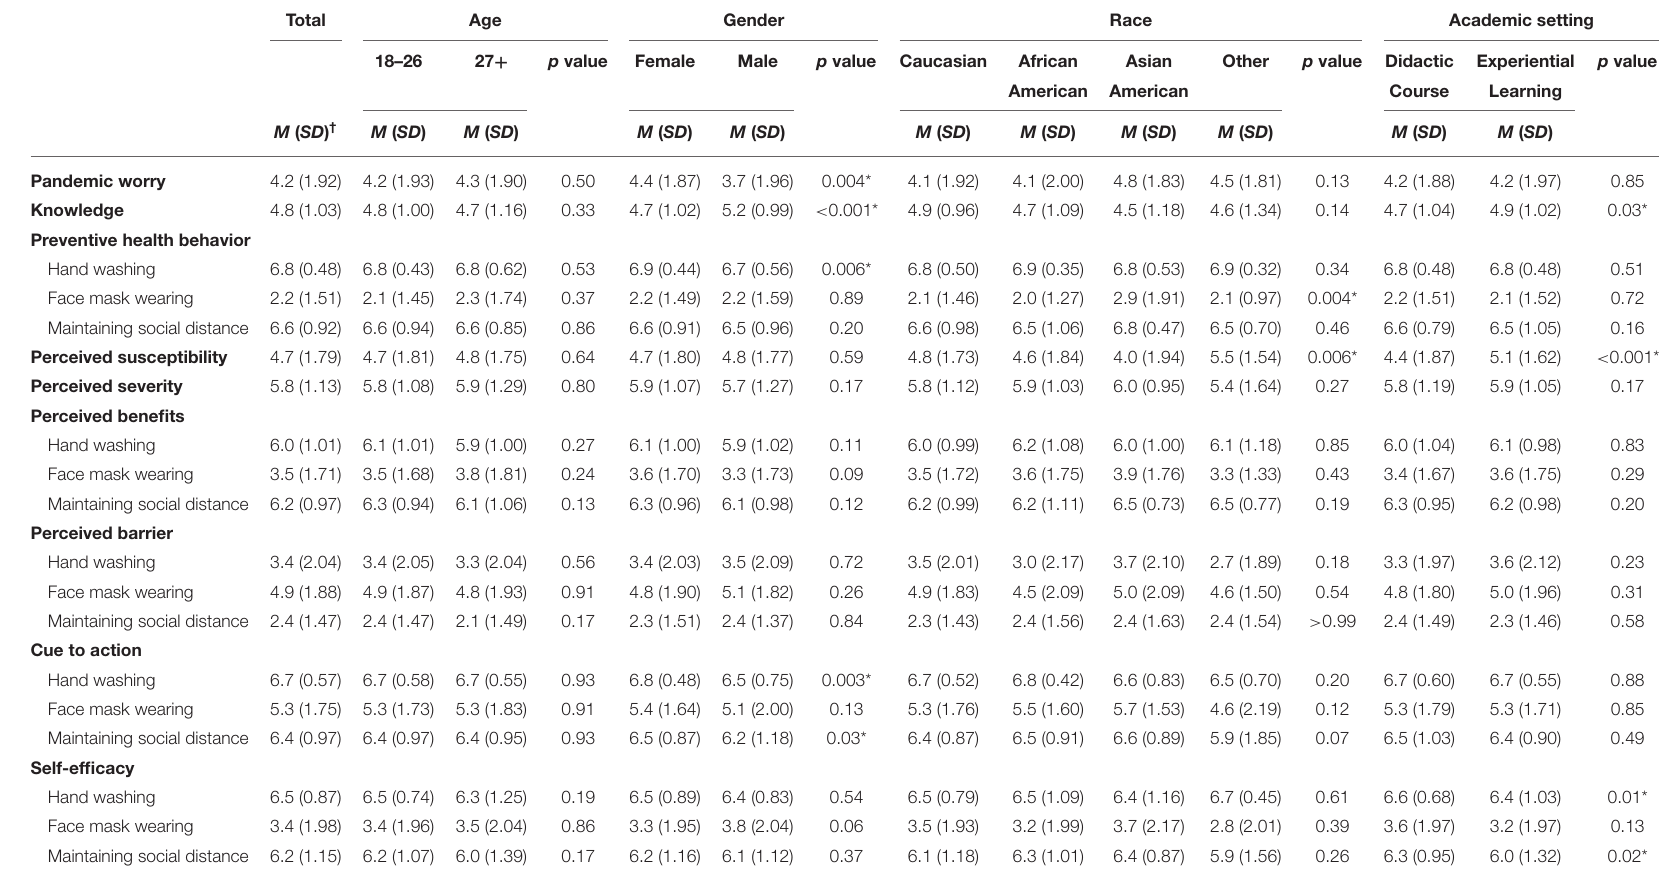
TABLE 2 | Pandemic worry, knowledge, and preventive health behaviors of study participants by age, gender, race, and academic setting. Total Age Gender Race Academic setting 18–26 27 + p value Female Male p value Caucasian African Asian Other p value Didactic Experiential p value American American